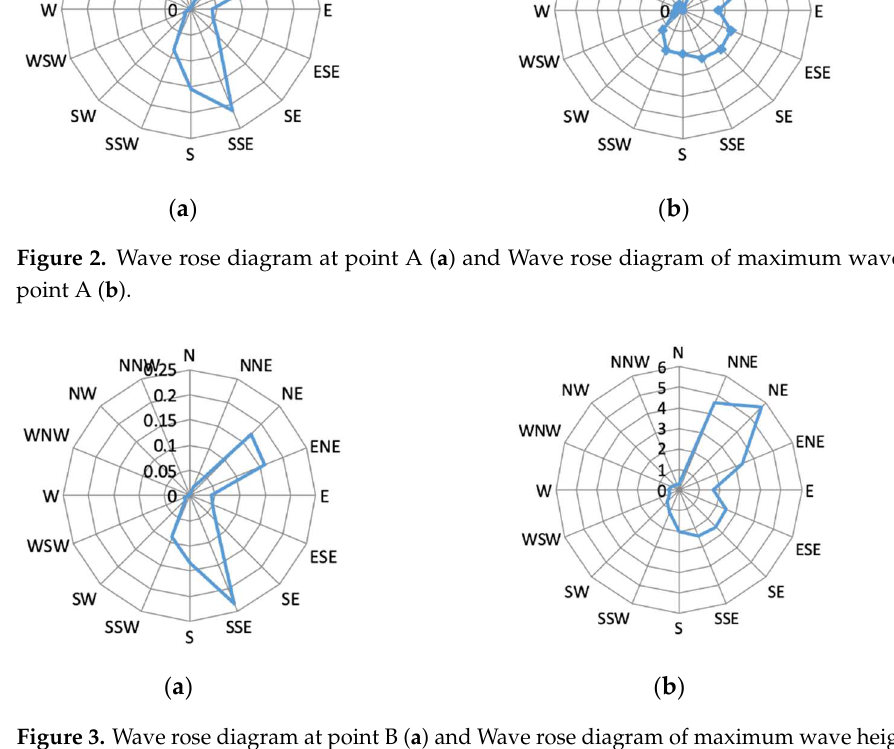
Figure 3. Wave rose diagram at point B ( a ) and Wave rose diagram of maximum wave height at point B ( b ).